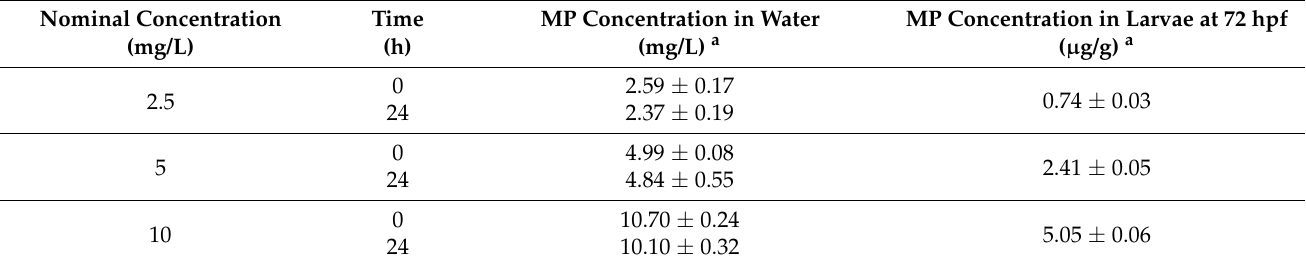
Table 1. Stability of MP during the experiment and concentration in zebrafish